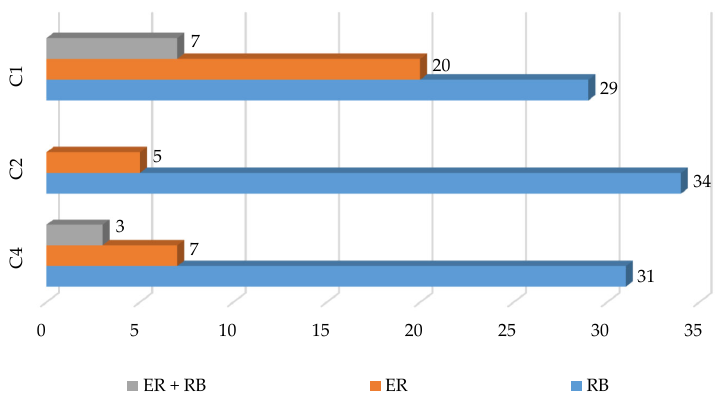
Figure 1. Number of animals with rhythmic breathing (RB) and eye response (ER) or both (RB + ER) in the 400 animals assessed by each operator (C4, C2, and C1). Table 5. Presence of rhythmic breathing (RB) and eye response (ER) or both (RB + ER) independent of and/or consequential to the formation of a false aneurysm (FA).